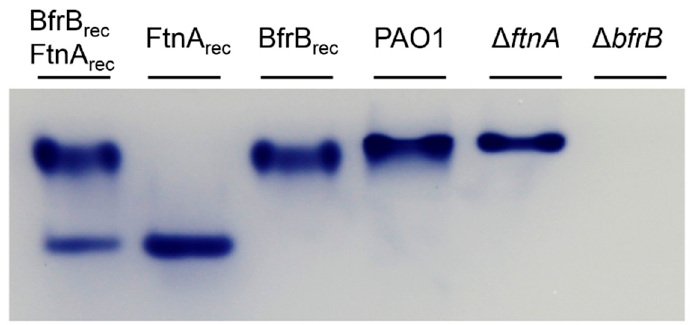
Figure 2. Iron stored in ferritin-like molecules visualized in native polyacrylamide gels stained with Ferene S. BfrB rec and FtnA rec were used as electrophoretic mobility standards, loaded as a mixture or alone. Lysates of PAO1 and ∆ ftnA cells grown aerobically for 24 h in LB media supplemented with 30 µ M Fe show an iron-stained band matching that of BfrB rec , whereas lysates of ∆ bfrB cells cultured similarly are characterized by the conspicuous absence of accumulated iron.